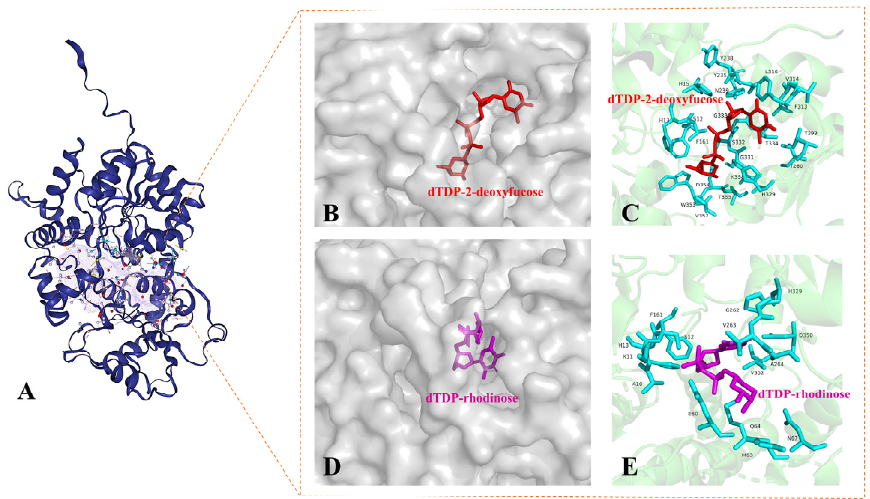
Figure 8. Homology model of AknK and docking analysis. ( A ) Homology model of AknK; the close- up view of the profile maps showing the active site binding as well as enlarged views of molecular docking of AknK with ( B , C ) dTDP-2-deoxyfucose; and ( D , E ) dTDP-rhodinose, respectively.